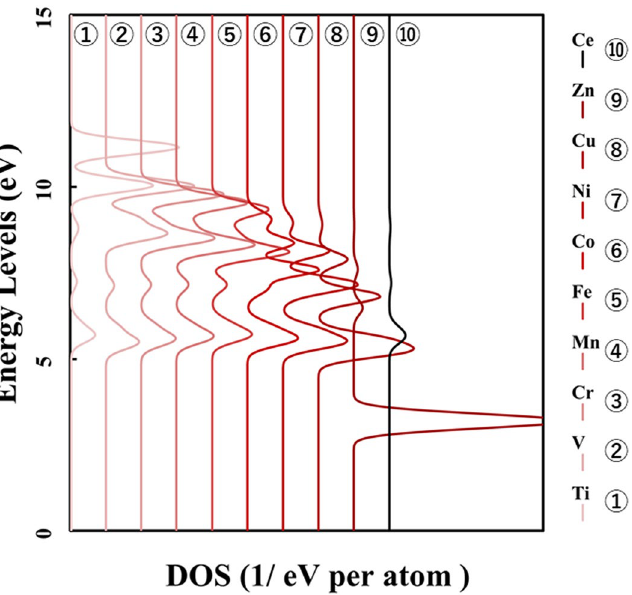
Figure 1. p-DOS for the 3d orbitals of the doped metal atoms in the M@Ce 12 O 8 36+ cluster model, the vacuum level is the reference energy level (M = Ti, V, Cr, Mn, Fe, Co, Ni, Cu, Zn, Ce).